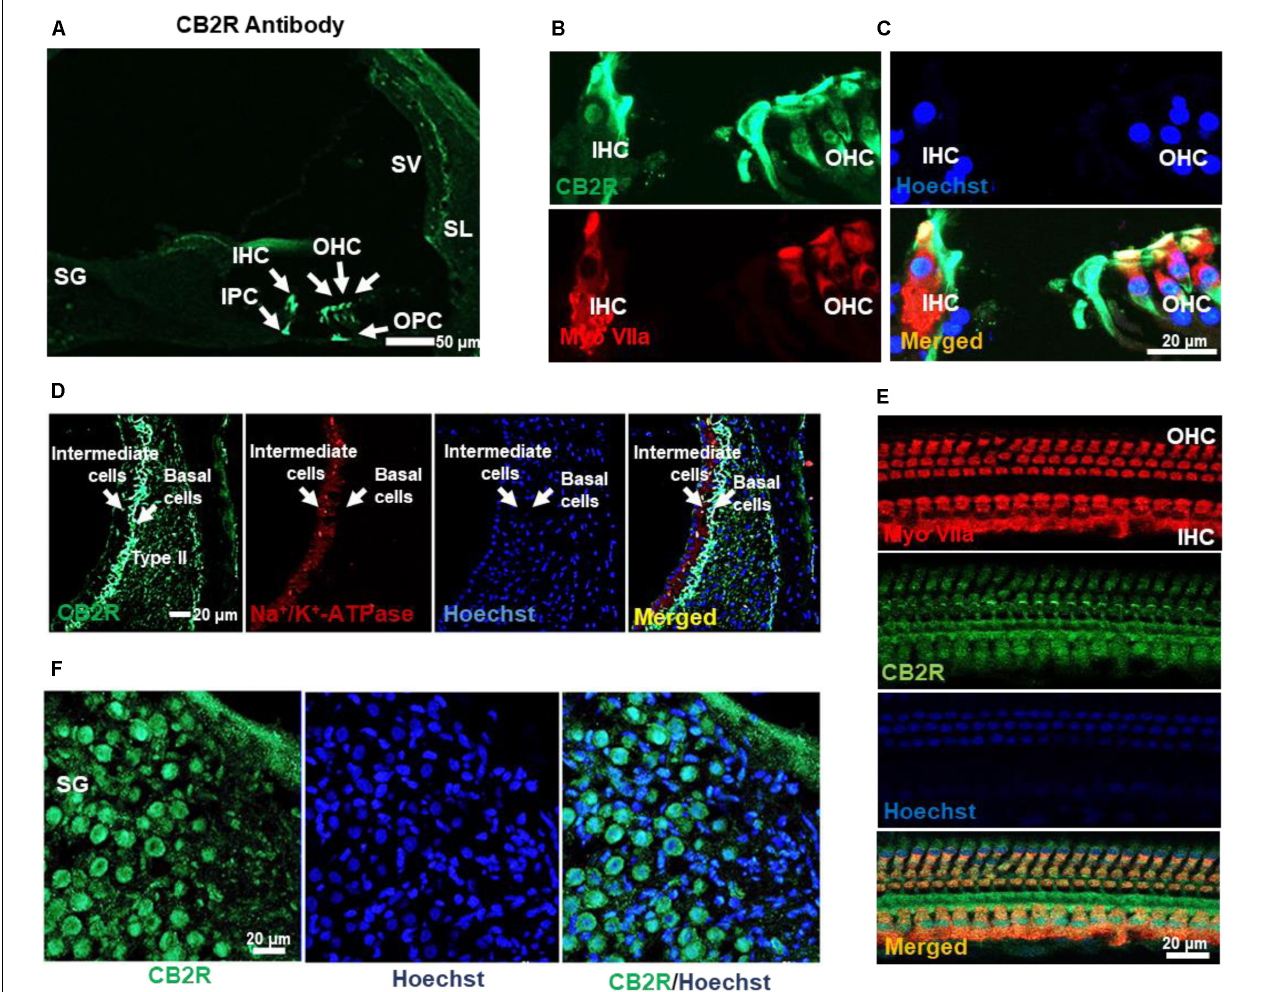
FIGURE 2 | Distribution of the CB2R in the rat cochlea. (A) Immunolabeling of mid-modiolar cochlear sections with CB2R antibody shows labeling of cells in the organ of Corti (green). Labeling was observed in the outer hair cells (OHC), inner hair cells (IHC), inner pillar cell (IPC), and outer pillar cell (OPC). (B) Co-labeling of the organ of Corti with antibodies for CB2R (green) and myosin VIIa (red) showed co-localization of these proteins in the OHC and IHC. (C) Staining of CB2R was also observed in the intermediate and basal cells of the SV and type II fibrocytes in SL. CB2R (green) showed some overlap with Na + /K + -ATPase α 1 subunit (red) in the SV. (D) CB2R was localized to the plasma membranes of SG. Approximately 60% of cells in this section were stained with both CB2R (green) and Hoechst (blue). (E) Co-labeling of CB2R and myosin VIIa in OHCs and IHCs in whole mount preparations of the organ of Corti shows that distribution of CB2R (green) is more widespread than that of myosin VIIa (red). Hoechst was used as a nuclear stain (blue) in (B–E) . Studies reported here were repeated in at least three different animals and similar results were